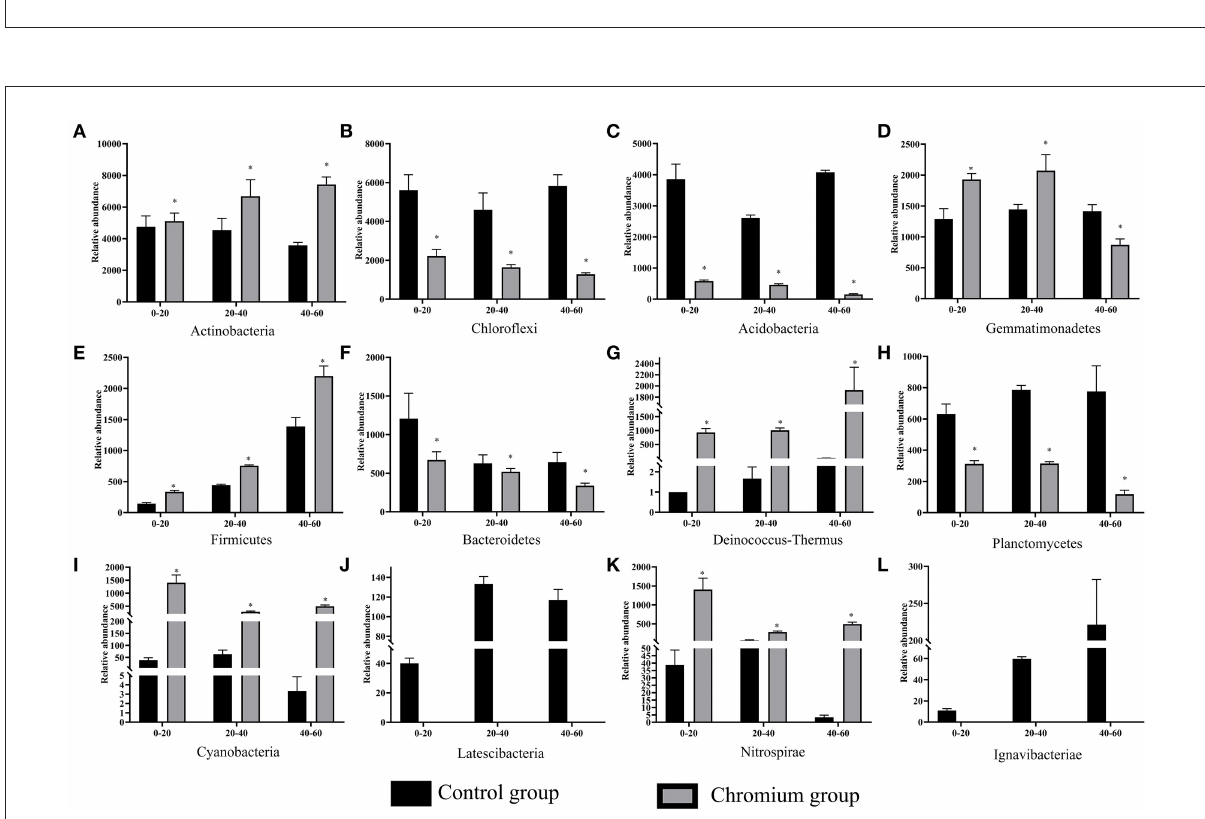
FIGURE5 Significant differences in bacterial community composition (A–L) were analyzed at the phylum level. Values in the same row with “*” were significantly different ( p < 0.05) at the same depth between the control and chromium groups, respectively. All data in the experiment represent three independent